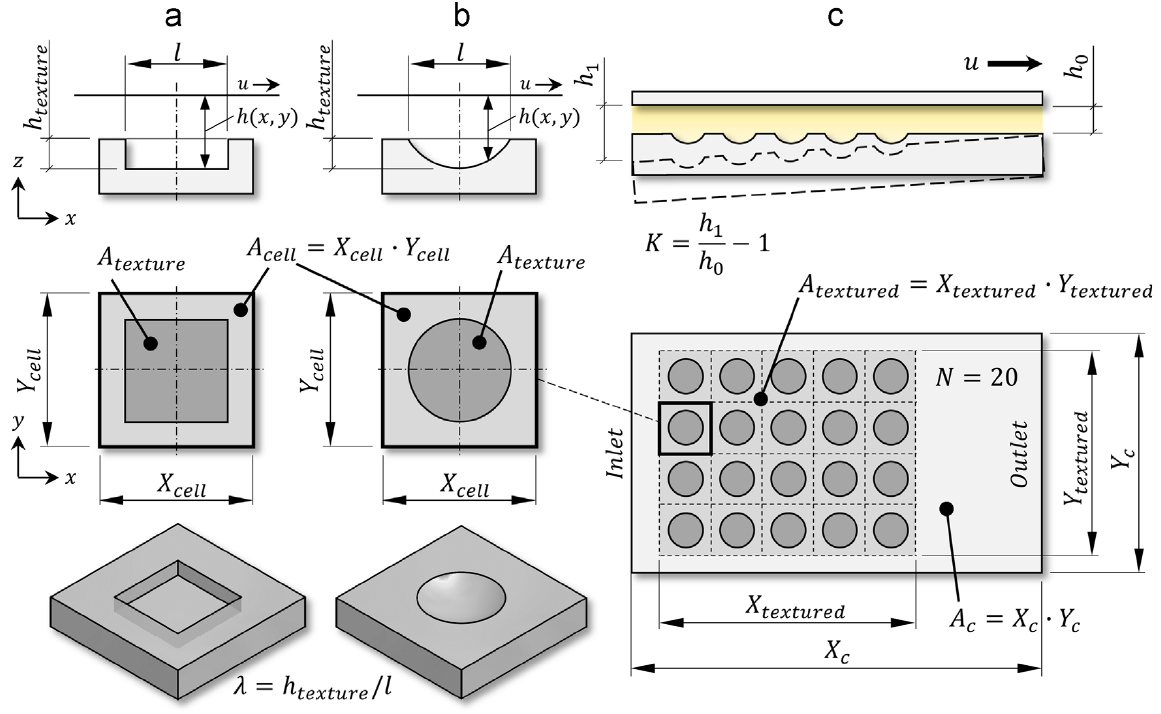
Figure 4. Texturing parameters for parallel/convergent slider bearings: ( a ) cuboid dimple with texture cell; ( b ) spherical dimple with texture cell and; ( c ) parallel/convergent slider bearing [61].